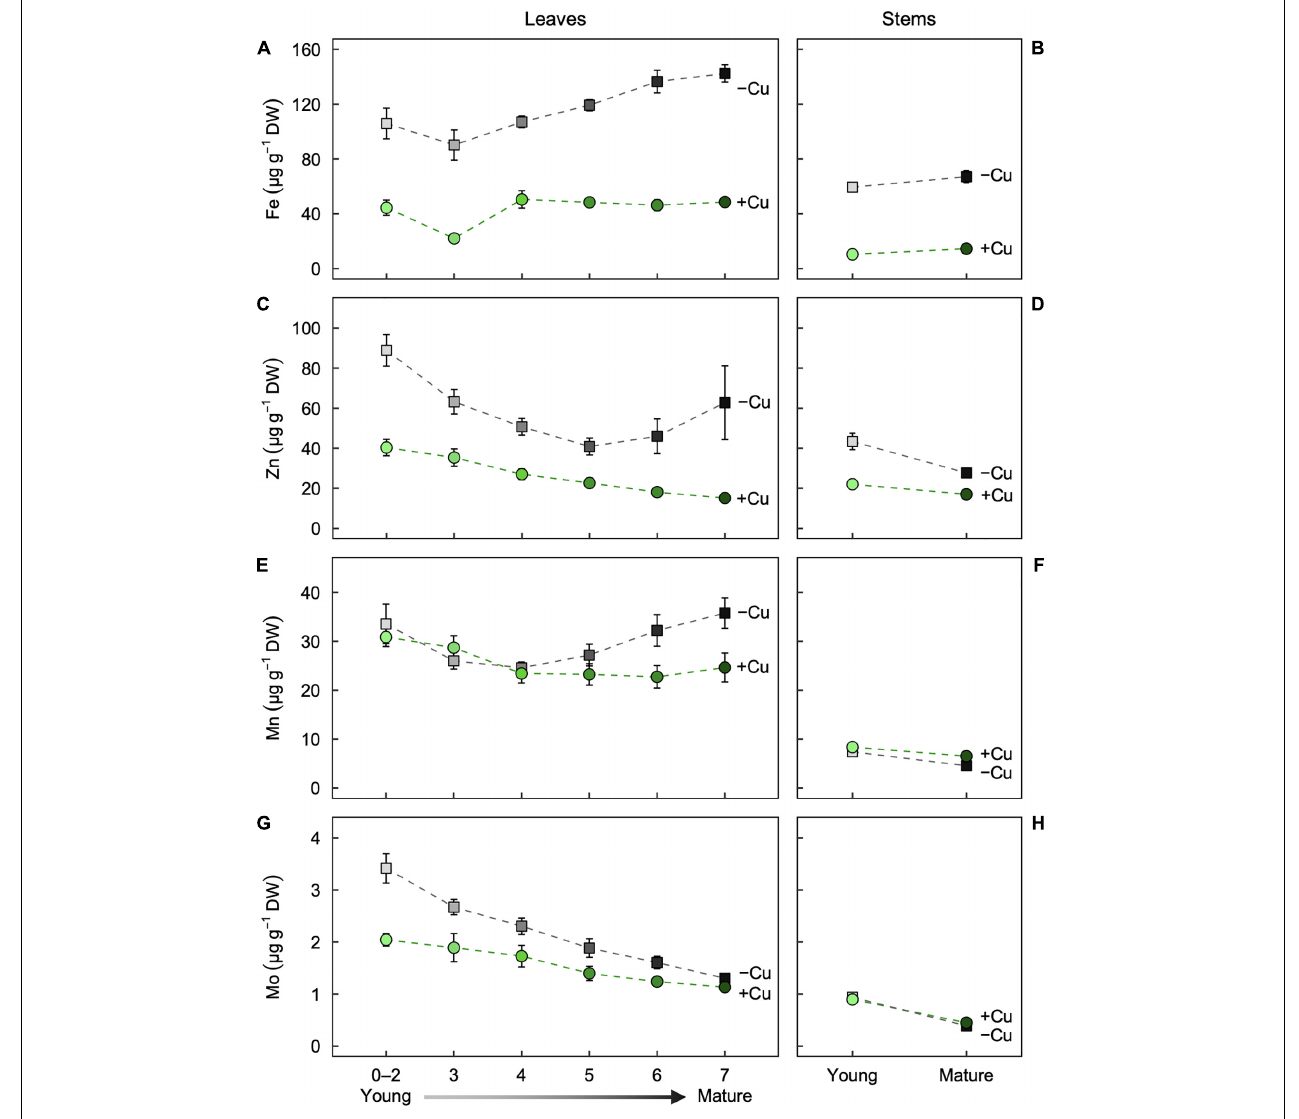
FIGURE 3 | Partitioning of the micronutrients (A,B) Fe, (C,D) Zn, (E,F) Mn, and (G,H) Mo as a function of age in (A,C,E,G) leaves and (B,D,F,H) stems of hybrid white poplar ( P. tremula × P. alba ) grown in +Cu (green circles) and –Cu (gray squares) conditions. Mean values ± SE ( n = 6). Results of two-way ANOVAs for the effects and interaction of tissue age and Cu feeding status on mineral partitioning in leaves as well as stems are shown in Table 1 .